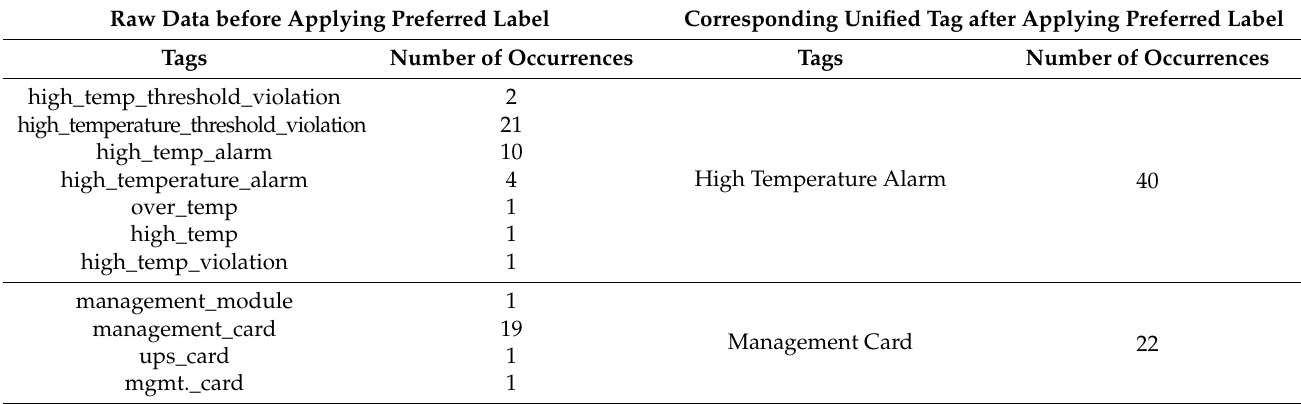
Table 5. Example of increase in density of low frequency tags resulting from addition of preferred label.